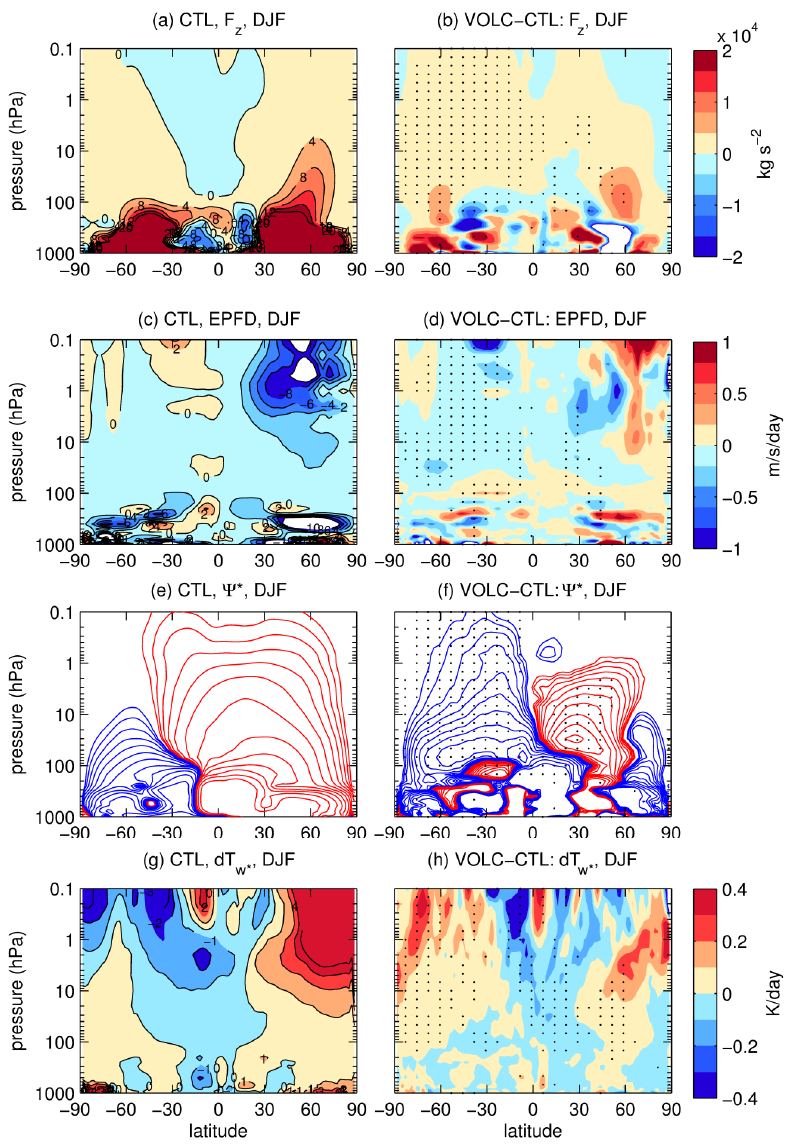
Figure 10. Selected TEM diagnostics for (left) the CTL ensemble and (right) anomalies for the VOLC grand ensemble. Shown are (a, b) vertical component of EP-flux, (c, d) EP-flux divergence, (e, f) residual circulation streamfunction and (g, h) heating due to residual vertical advection. Contours in (a) are in units of 1 × 10 4 kgs − 2 . Stream function contours in (e) and (f) are red for positive values and blue for negative values, and are log-spaced, ranging from 10 to 1 × 10 4 kgm − 1 s − 1 in panel (e) and 1 to 100kgm − 1 s − 1 in panel (f)